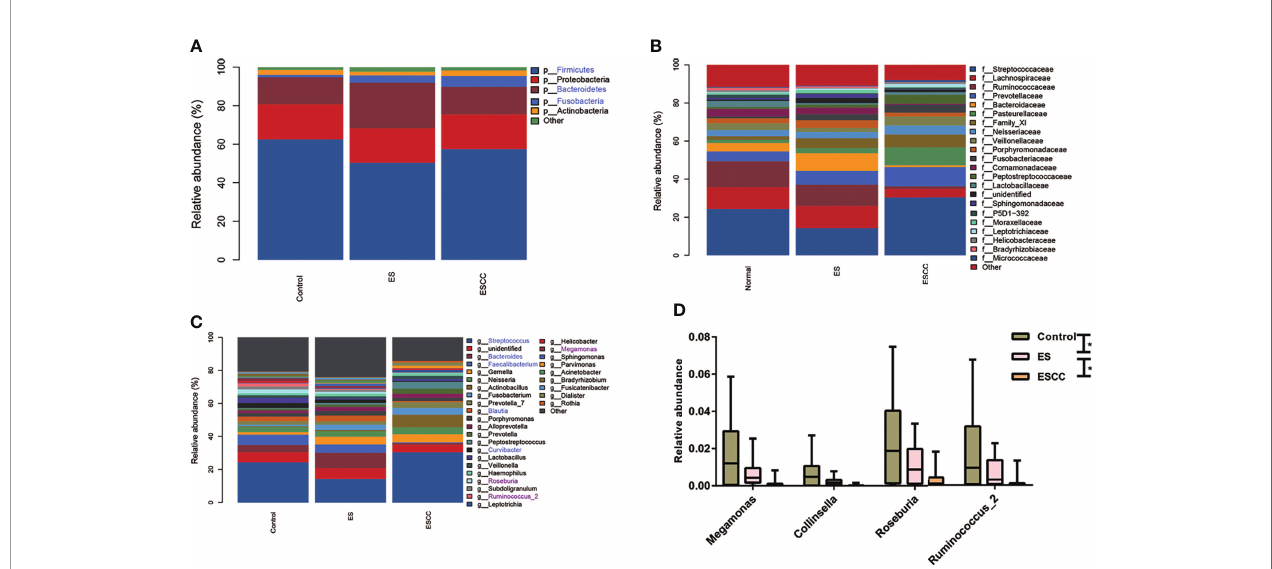
FIGURE 2 | Comparison of relative abundance among each group Barplots of the relative abundance of the main bacterial taxa at (A) phylum, (B) family and (C) genus level for the control, ES and ESCC group. Signi fi cant taxa were highlighted in the blue font. (D) Mean relative abundance of continuous changing genera among the groups. Signi fi cant taxa were highlighted in the purple font. Data were reported as min to the max with the line at median. * p < 0.05.